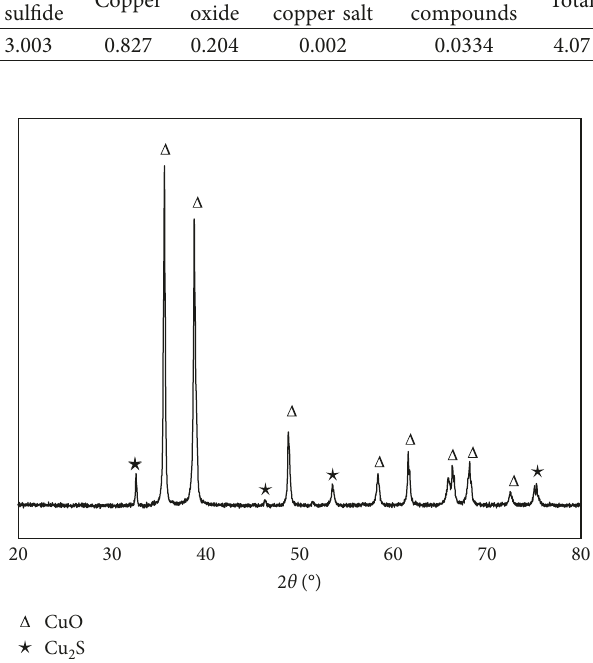
Figure 1: XRD pattern of the selected CuO